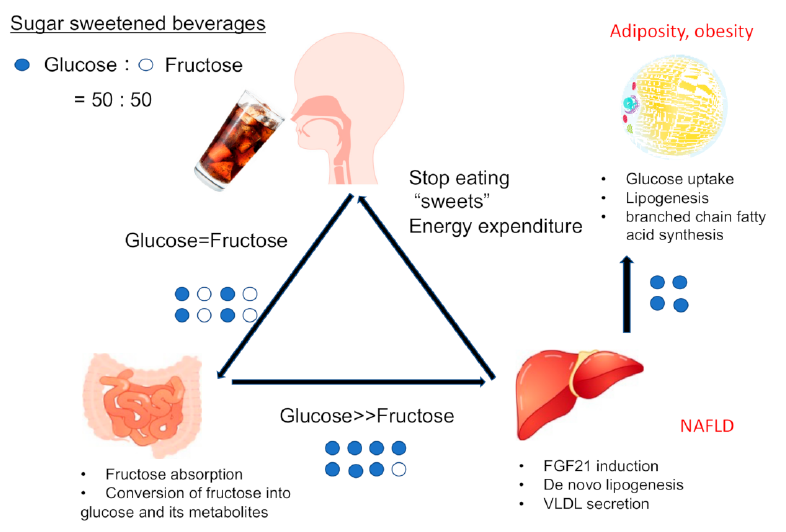
Figure 3. High-fructose corn syrup and